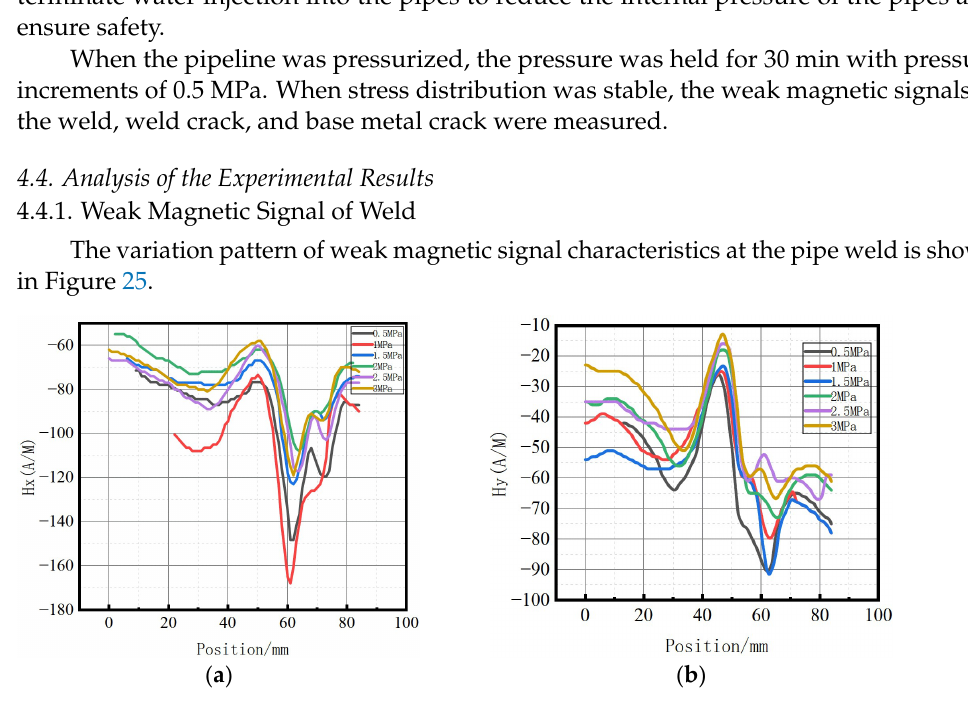
Figure 24. Experimental setup. ( a ) Experimental arrangement; ( b ) weld, weld crack, and base metal crack; ( c ) pressure suppression equipment.